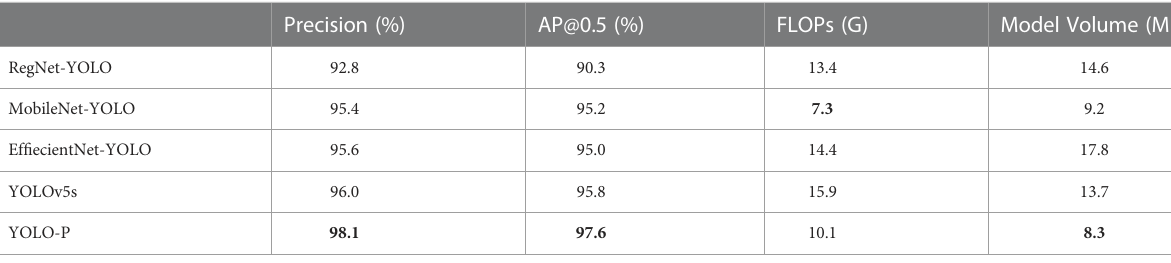
Bold means the best score achieved in that category.